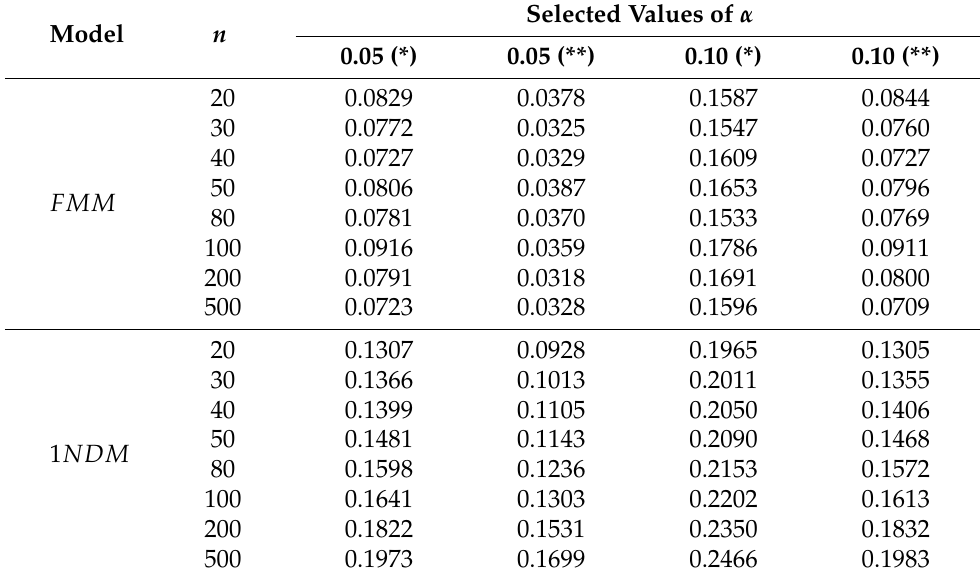
Table 11. EMAS test: proportion of times of global rejections when using the FMM and the 1NDM with (*) and without (**) applying the Bonferroni’s correction (based on 5000 simulations). Model